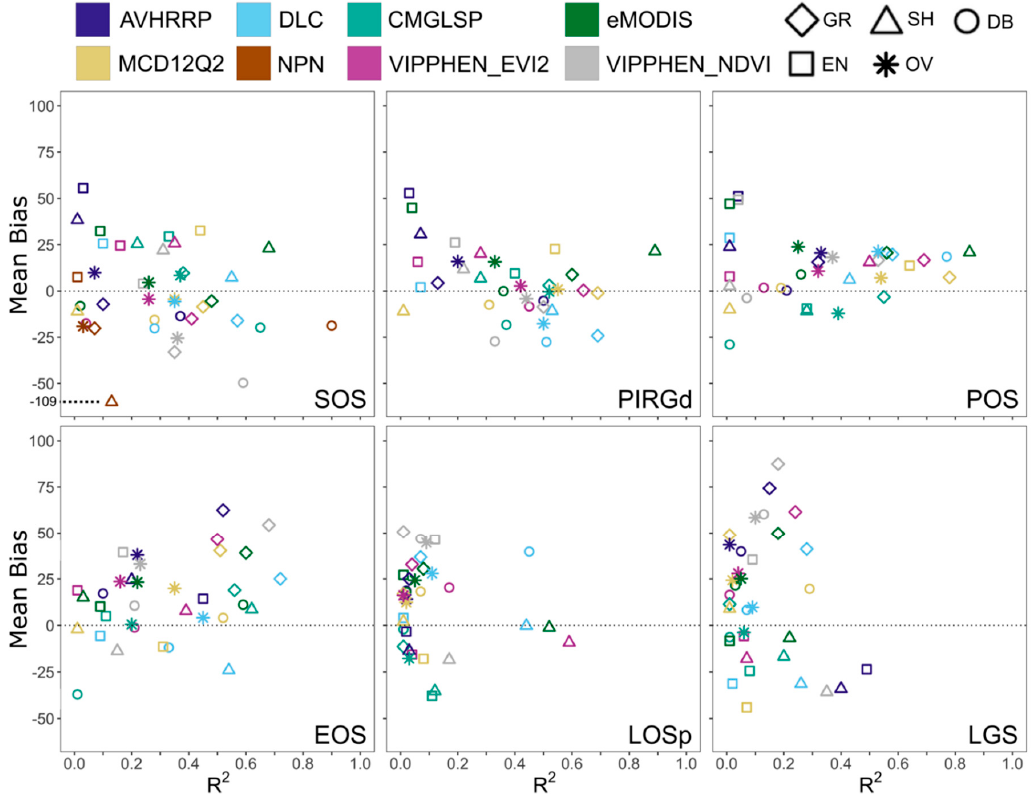
Figure 3. R 2 and mean bias (in days) for six phenology metrics classified by land cover type identified in PhenoCam metadata and overall for all data points. The phenology metrics are start of season (SOS), peak instantaneous rate of green-up date (PIRGd), peak of season (POS), end of season (EOS), length of spring (LOSp) and length of growing season (LGS). The classifications are grasslands (GR), shrublands (SH), deciduous / broadleaf (DB), evergreen (EN) and overall (OV). In general, this illustrates how the overall evaluation falls between the landcover-specific values for each dataset and metric combination.